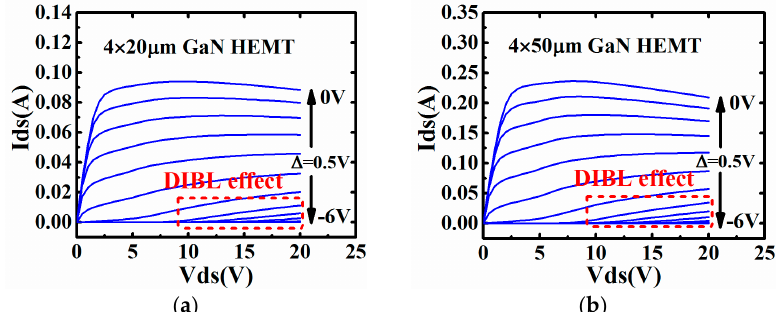
Figure 1. Drain induced barrier lowering (DIBL) effect in Static IV curves of 0.1 µ m AlGaN/GaN high electron mobility transistor (HEMT) with different gate width: ( a ) 4 × 20 µ m and ( b ) 4 × 50 µ